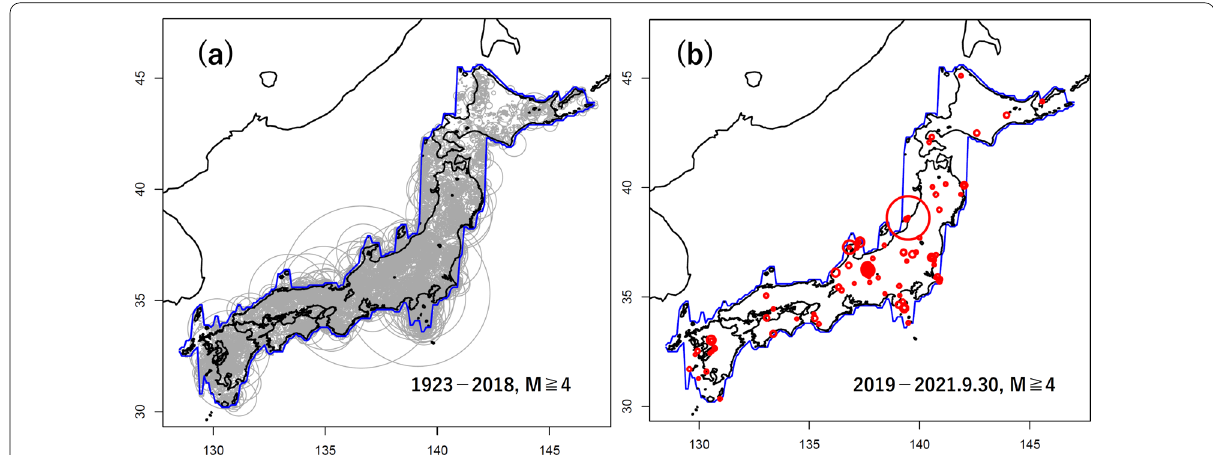
Fig. 1 Epicenter locations within inland Japan (blue boundary curve). a Earthquake locations of the target data from the JMA catalog (1923–2018, M 4.0) applied to estimate the models, in addition to those of the Utsu catalog (1885–1922, M ≥ (2019 to September 2021, M 4.0) applied for evaluating forecast of ≥